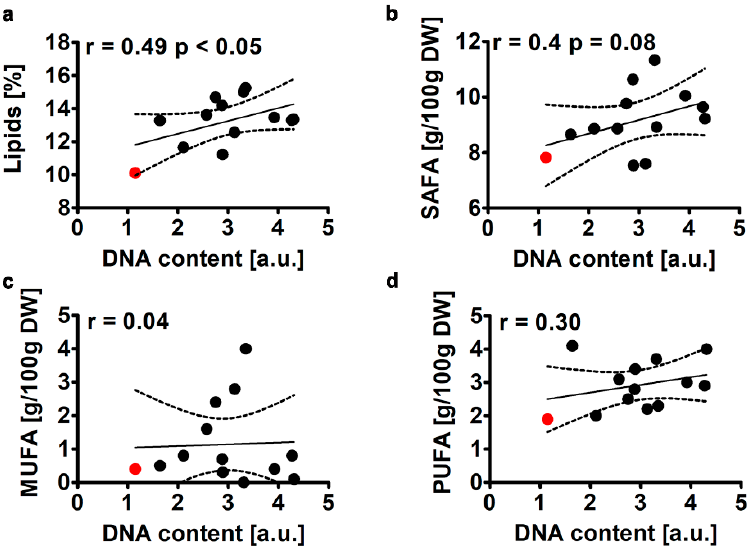
Figure 2. Colchicine and cytochalasin B-mediated effect on the levels of total lipids ( a ), SAFA ( b ), MUFA ( c ) and PUFA ( d ) in the microalga Planktochlorella nurekis . Correlation analysis between lipid content ( a ), SAFA ( b ), MUFA ( c ), PUFA ( d ) and DNA content. Twelve CC-treated clones were considered (black dots). WT cells are denoted as a red dot. Results represent the mean from three independent experiments. The levels of SAFA, MUFA and PUFA were calculated per 100 g of dry weight. The 95% confidence interval is shown. Correlation analysis of the data was performed using a Linear Correlation (Pearson r) test. DW, dry weight.